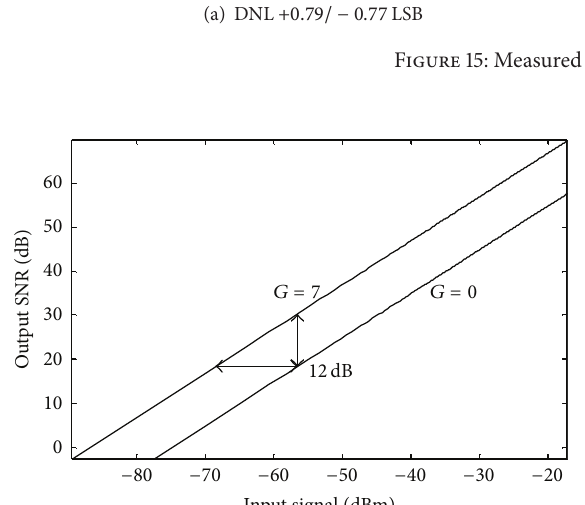
Figure 16: Measured 12dB ADC dynamic range